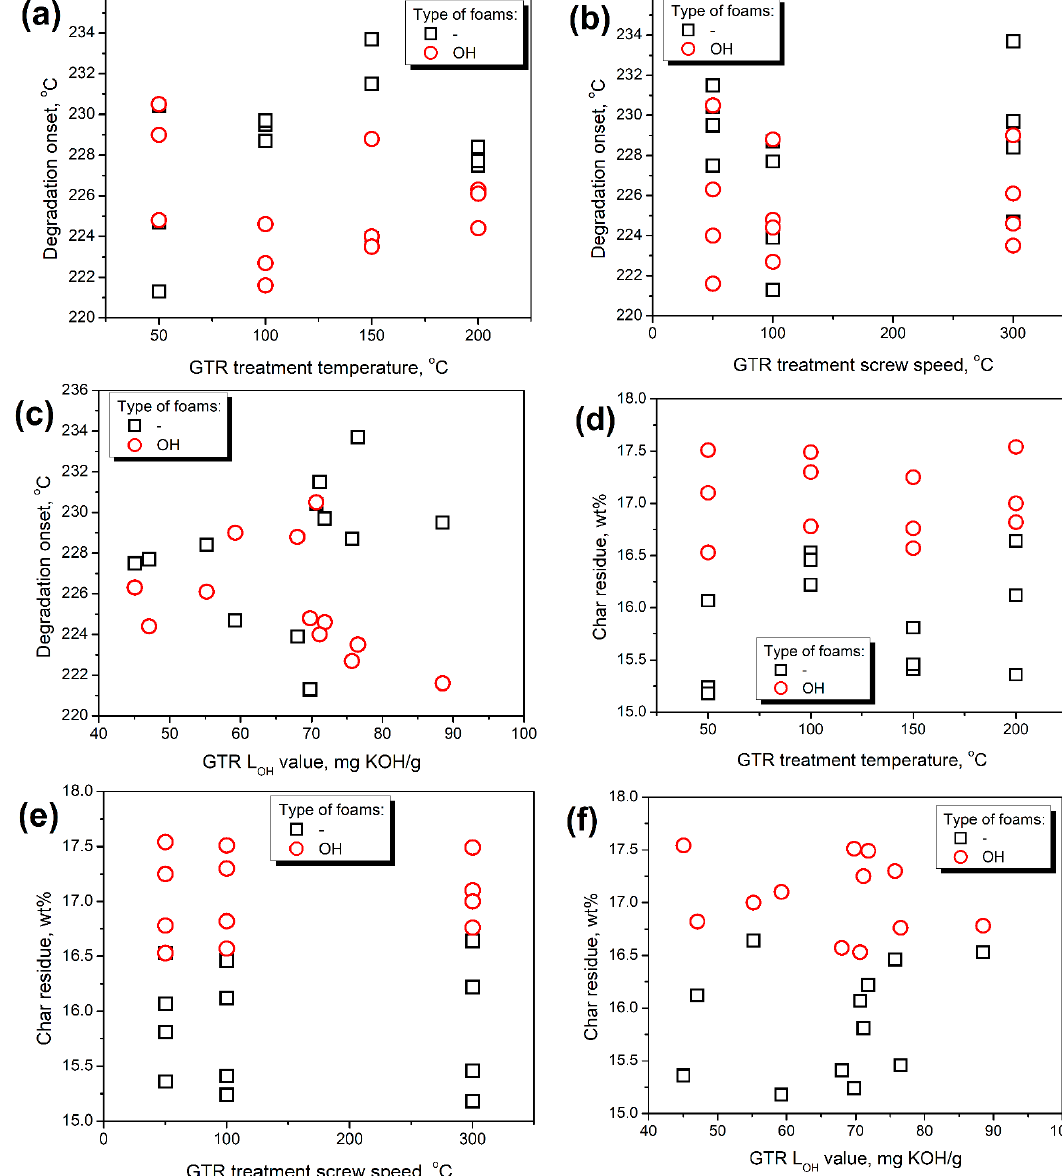
Figure 14. The impact of ( a , d ) GTR treatment temperature, ( b , e ) GTR treatment screw speed, and ( c , f ) GTR L OH value on the ( a , b , c ) degradation onset, and ( d , e , f ) char residue of prepared PU/GTR composites.